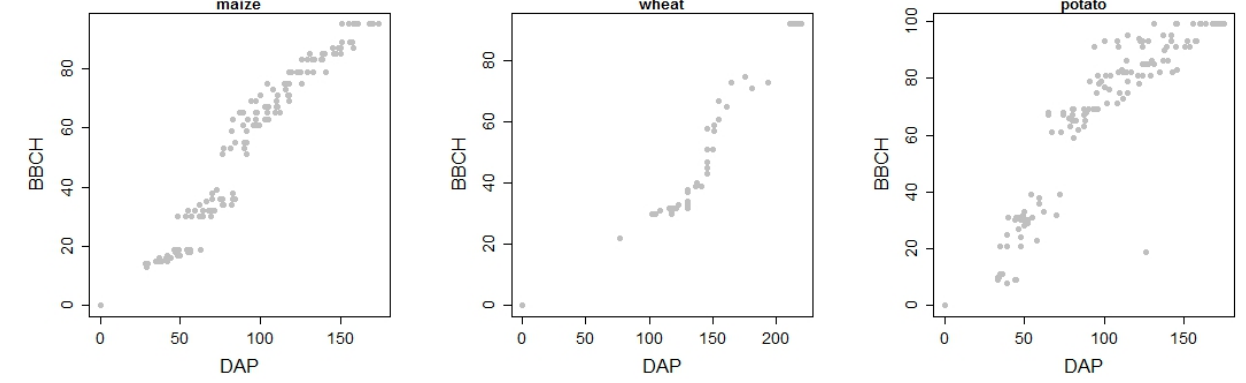
Figure 6. Observed BBCH codes versus days after planting/sowing (DAP) for maize, winter wheat, and potato for the period 2015–2017. and potato for the period